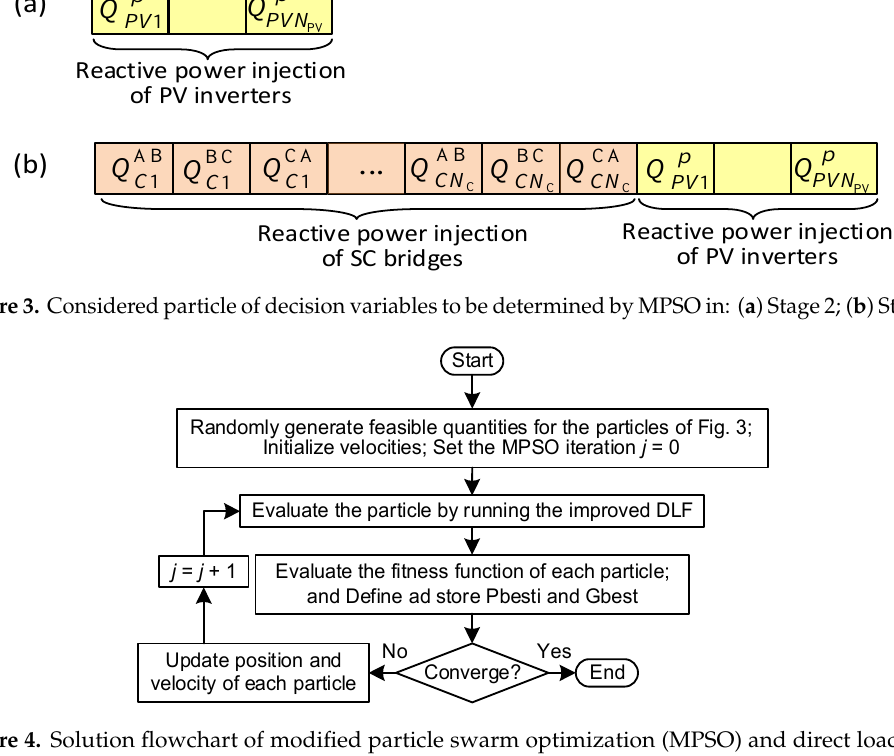
Figure 5. Considered 145-bus Australian distribution network: ( a ) Medium-voltage (MV) feeder; ( b ) unbalanced low-voltage (LV) feeder supplied from bus-20 of the MV feeder.